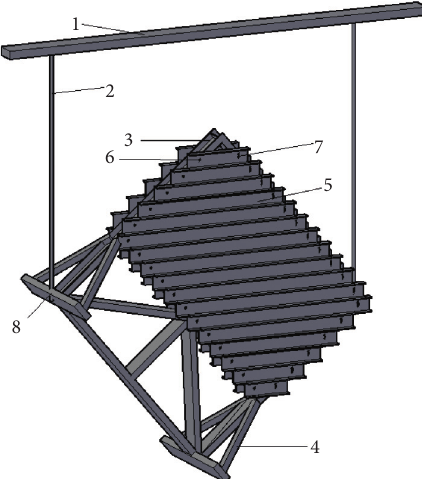
Figure 2: Three-dimensional effect drawing of a new type of similarity simulation experiment table.